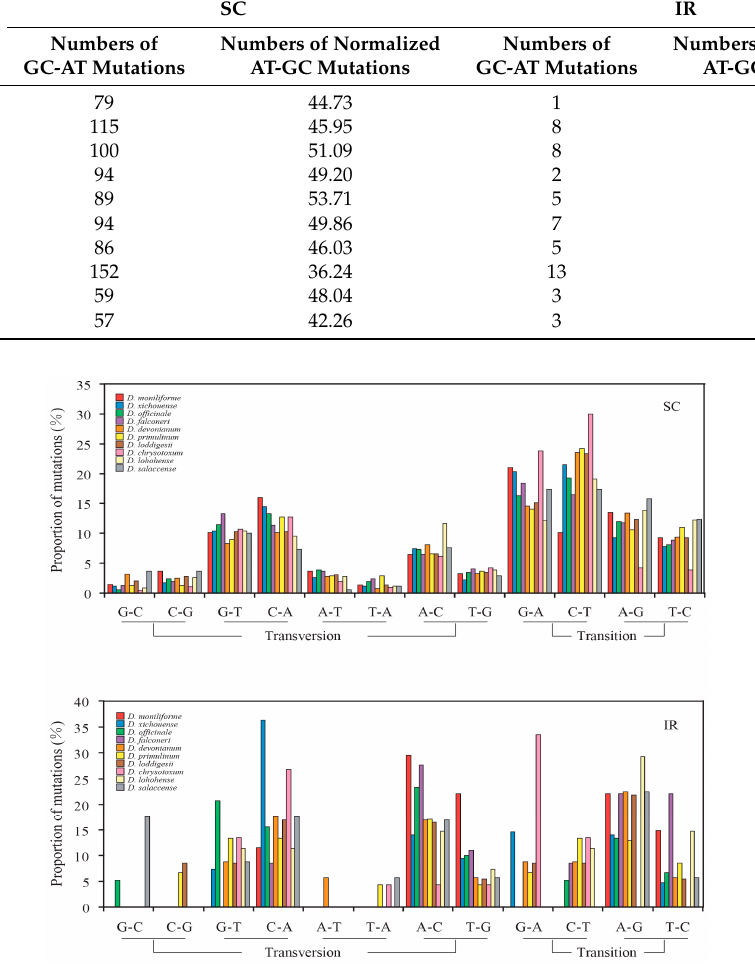
Figure 6. Proportion of the six nucleotide-pair mutations estimated from protein-coding genes. In contrast to the counting results of non-coding loci, the frequencies of transitions are higher than that of transversions in both SC and IR regions.